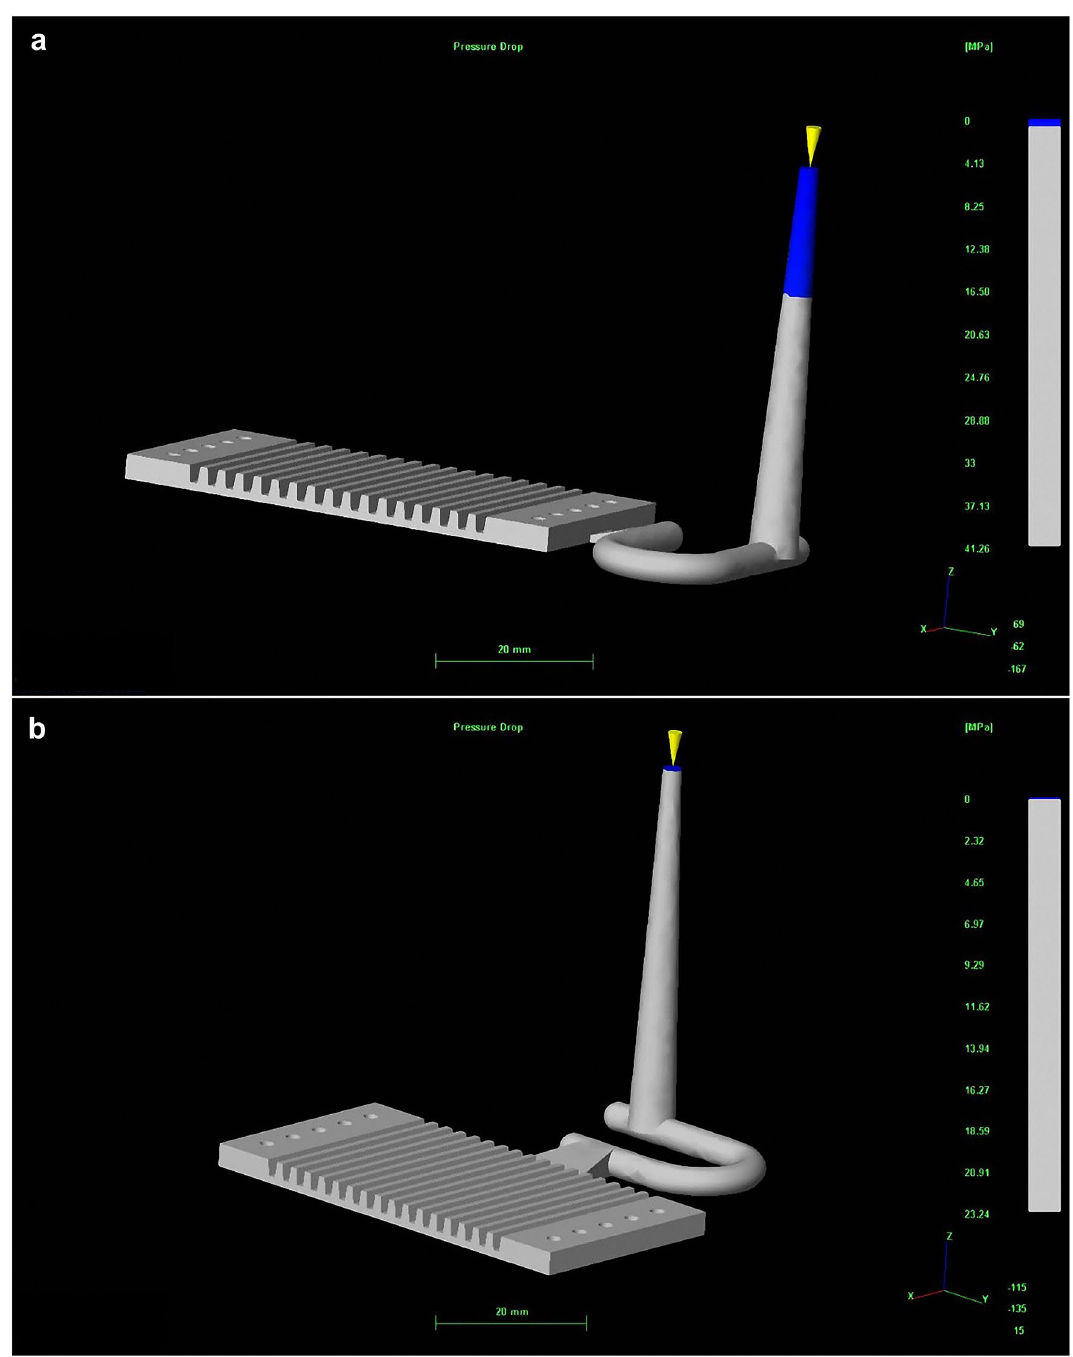
Figure 6. Different entrance directions of PMMA bipolar plate: ( a ) top, and ( b ) side (version number: MOLDFLOW ADVISER 2019, URL link: https:// www. autod esk. com/ produ cts/ moldfl ow/ overv